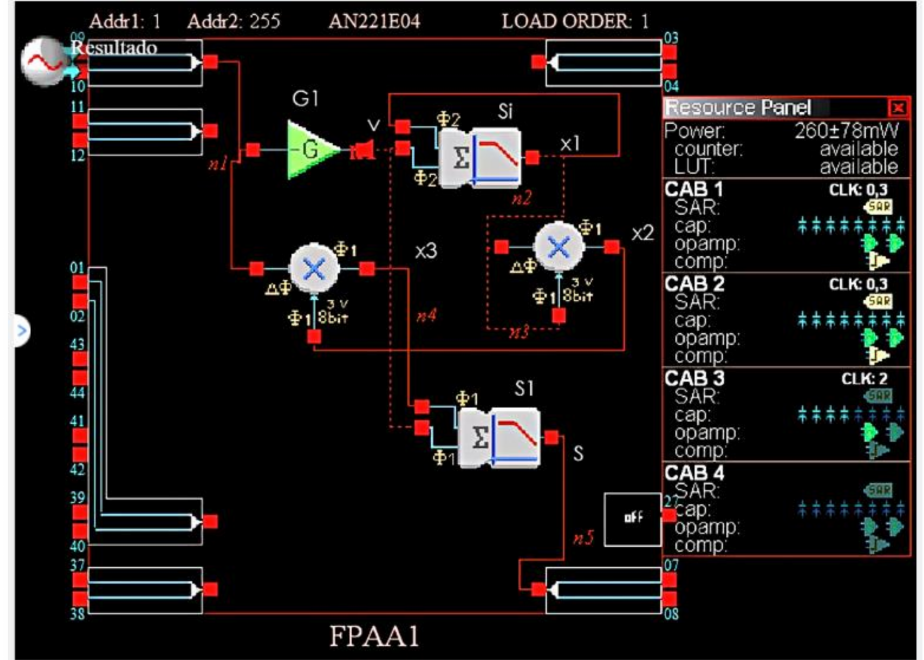
Figure 5. Schematic of FPAA memristor